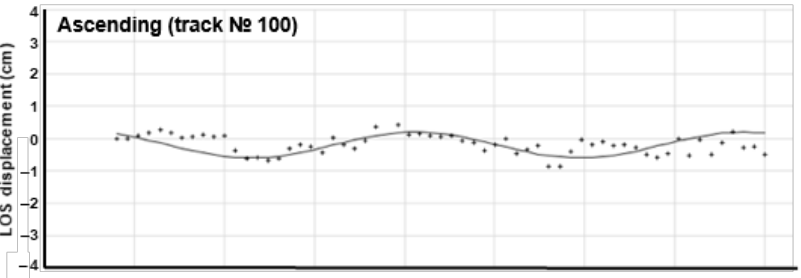
Figure 8. Time-series of ISBAS-derived cumulative LOS ground displacement for point A (indicated in Figure 6), the Right Bank landslide (also known as the Pravoberezhniy landslide).